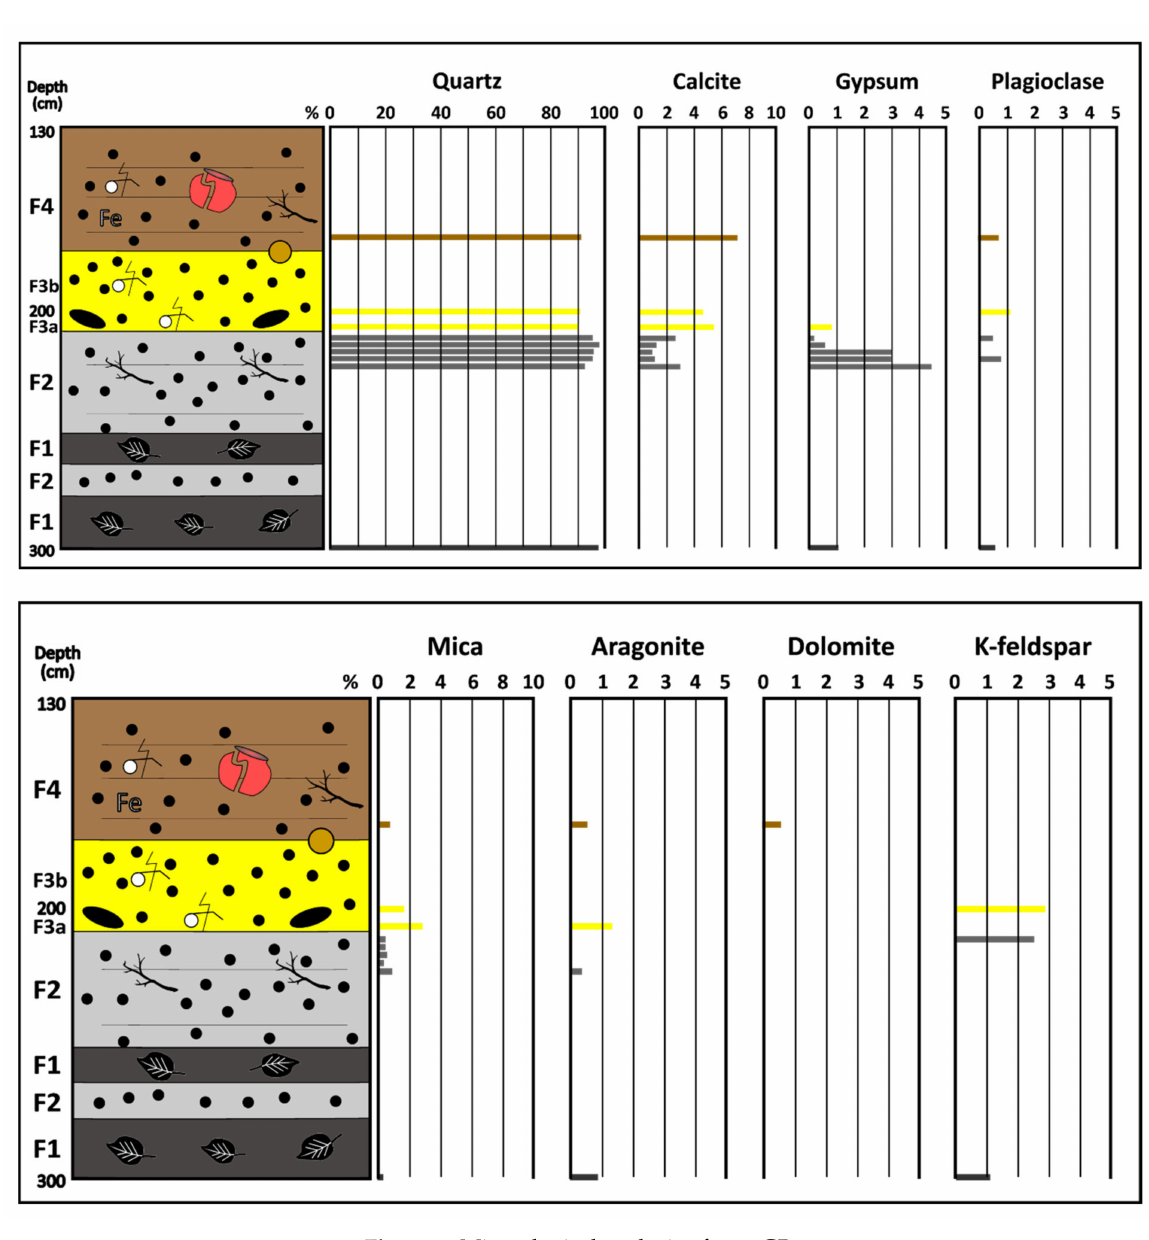
Figure 3. Mineralogical analysis of core